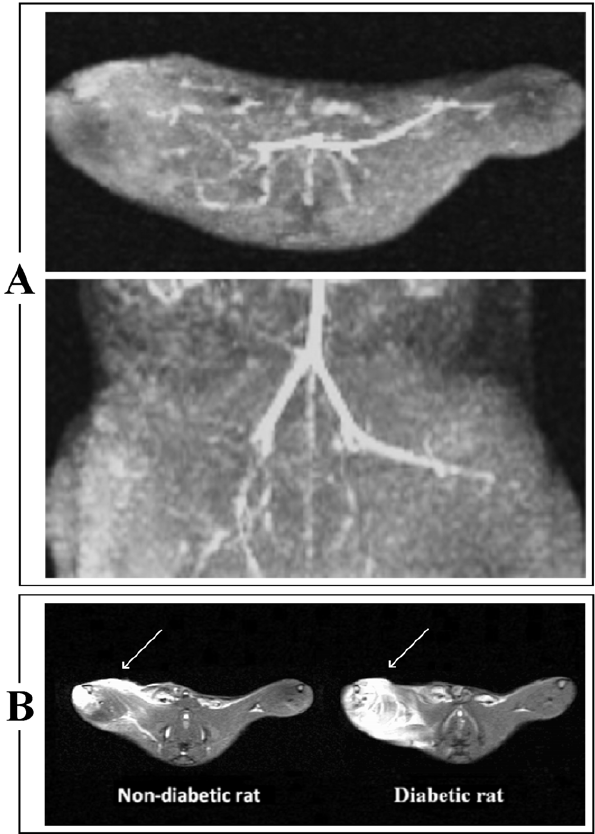
Figure 3. Representative MR Angiography (MRA) and Short Time Inversion Recovery (STIR) images. Panel A: MRA shows a signal void due to discontinuation of flow in the right common iliac- femoral artery. Panel B: Axial STIR images shows an ‘‘oedema-like’’ hyperintense signal (indicated by white arrows) on the occluded (right) muscle in both non-diabetic and diabetic rat. This signal changes is more extensive in the diabetic rat.